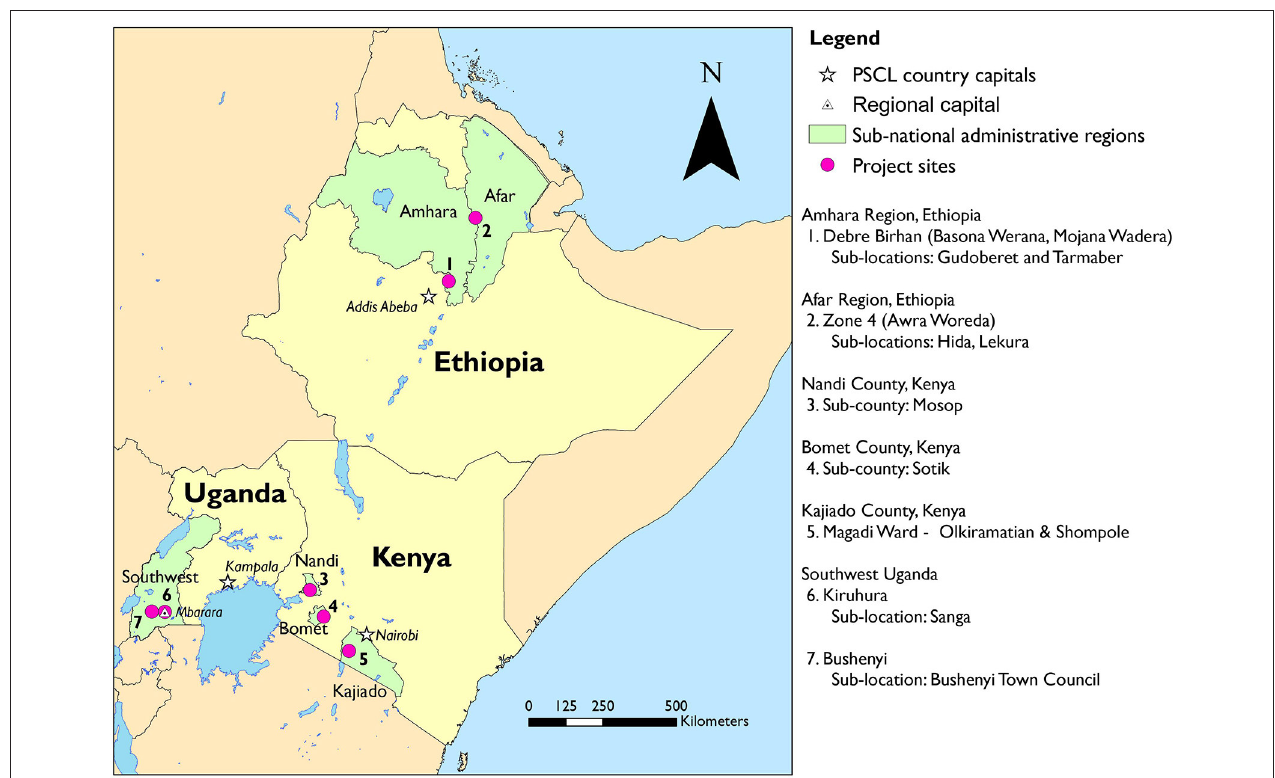
FIGURE 1 | Map of the five research sites. Amhara: Tarmaber and Gudoberet, Debre Birhan in Amhara Region, Ethiopia; Afar: Hida and Lekura, in Afar Region, Ethiopia; Kajiado: Olkirimatian and Shompole Group Ranches, Kajiado, Kenya; Nandi and Bomet Counties, Kenya; SW Uganda: Sanga in Kiruhura District, Uganda. Source: Michael Graham,